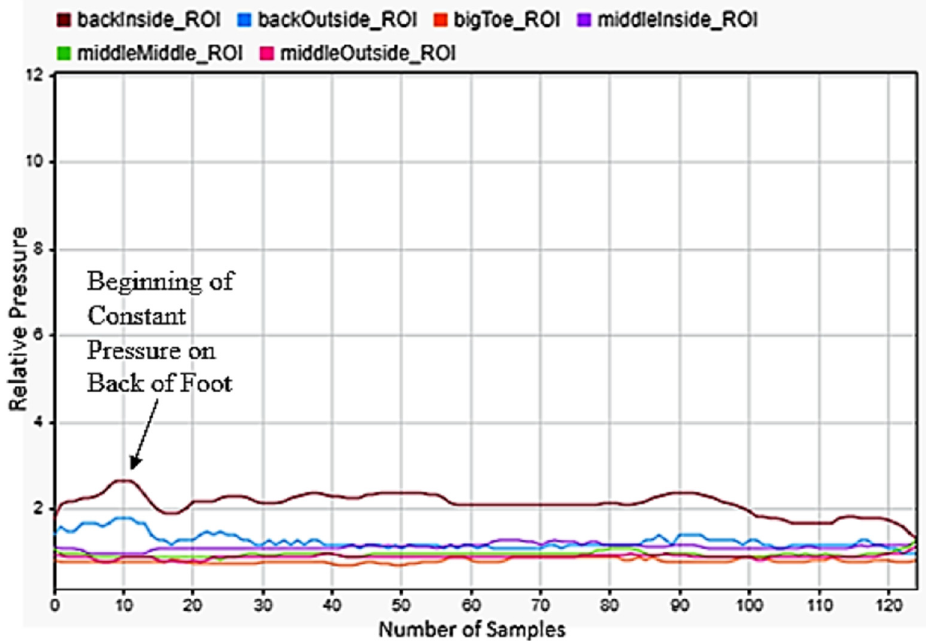
Figure 10. Squatting motion sensor data for the left